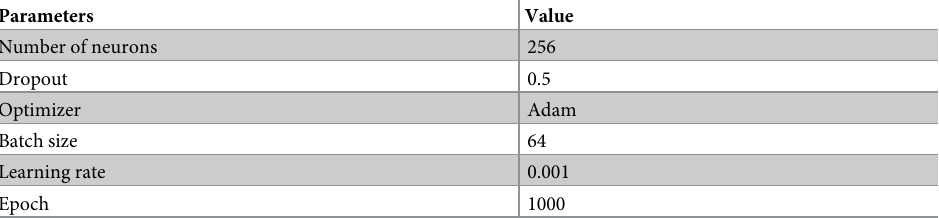
Table 2. Parameter setting to train the proposed network